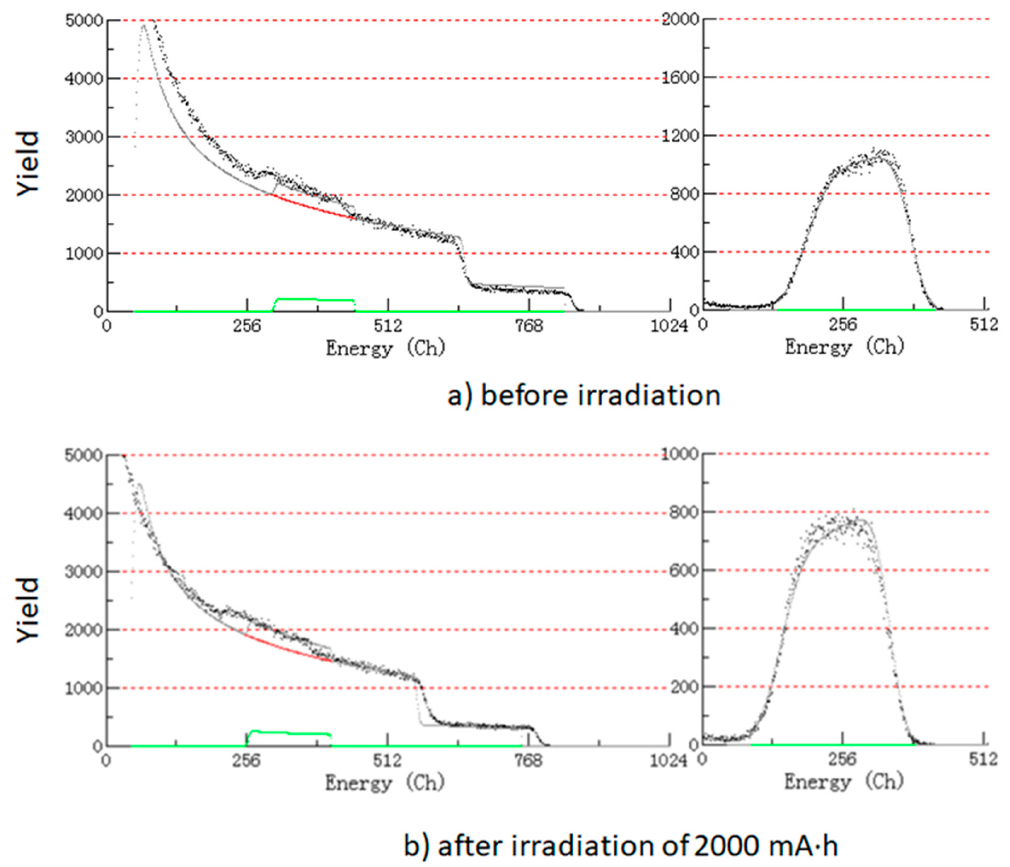
Figure 5. Rutherford backscattering spectrometry (RBS) profile (left side) and elastic recoil detection analysis (ERDA) profile (right side) of ( a ) Si-DLC film before irradiation and ( b ) Si-DLC film after irradiation of 2000 mA·h.